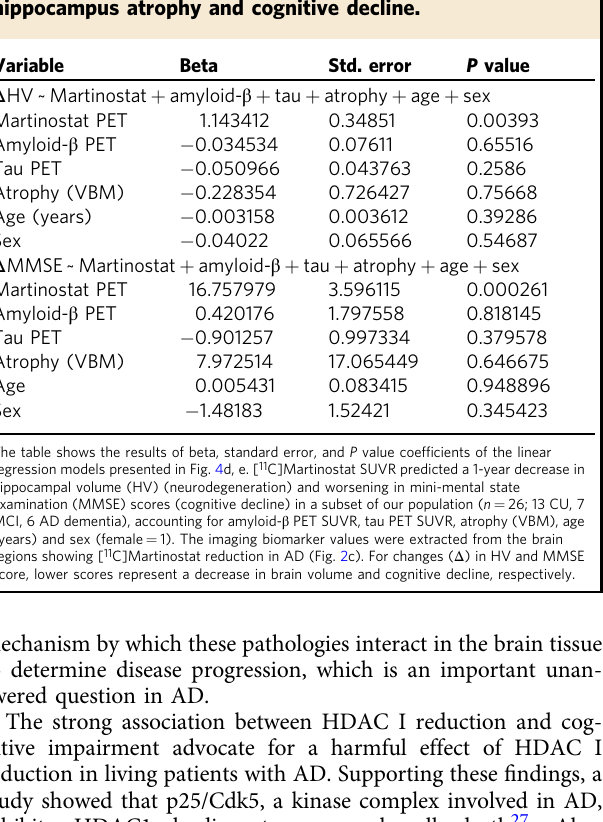
Fig. 4 [ 11 C]Martinostat SUVR is associated with Alzheimer ’ s disease pathophysiology and predicts longitudinal neurodegeneration and cognitive decline. T -statistical parametric maps show the results of voxel-wise linear regressions (left side panel) and scatter plots (right side panel) the results of Pearson correlations in regions showing [ 11 C]Martinostat reduction in AD (Fig. 2c) between [ 11 C]Martinostat PET and: a amyloid- β PET ( n = 45). b tau PET ( n = 44). c cognition measured with MMSE score ( n = 48). [ 11 C]Martinostat SUVR was associated with AD pathophysiology in the posterior cingulate, precuneus, inferior parietal, and lateral temporal cortices but not in other brain regions. Green, yellow, and red dots represent CU, MCI, and AD individuals who underwent amyloid- β or tau PET scans at the MCSA site, respectively. Linear regressions voxel-wise (left side panel) and in scatter plots within signi fi cant brain regions (right side panel) show that [ 11 C]Martinostat SUVR predicts 2-year d hippocampal atrophy ( n = 26) and e cognitive decline ( n = 23) accounting for amyloid- β , tau, atrophy, age, and sex. The error bands represent a 95% Con fi dence Interval. For changes in hippocampal volume and MMSE score, lower scores represent a decrease in brain volume and cognitive decline, respectively. All the t -statistical maps were false discovery rate corrected for multiple comparisons at P < 0.05. Source data are provided as a Source Data fi le. Table 2 [ 11 C]Martinostat SUVR predicts longitudinal hippocampus atrophy and cognitive decline.